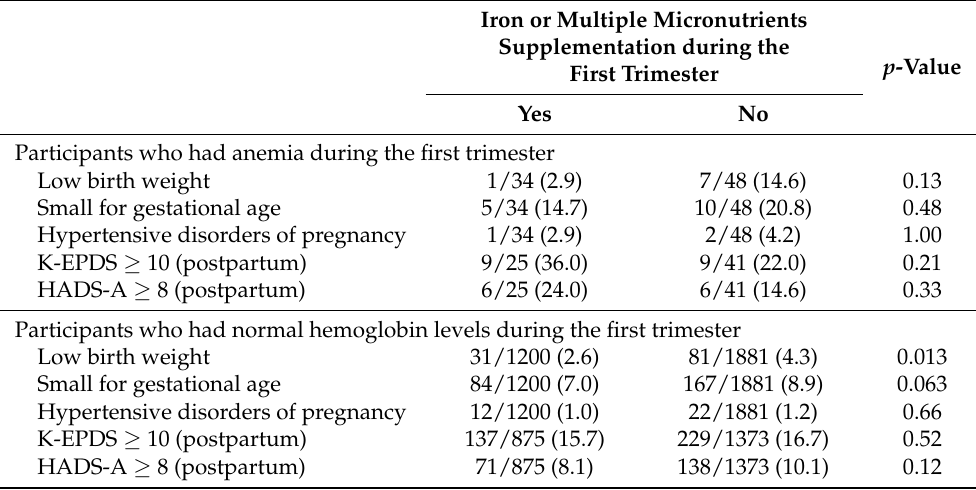
Table 6. Comparison of adverse outcomes between participants who received and those who did not receive iron supplementation during the first